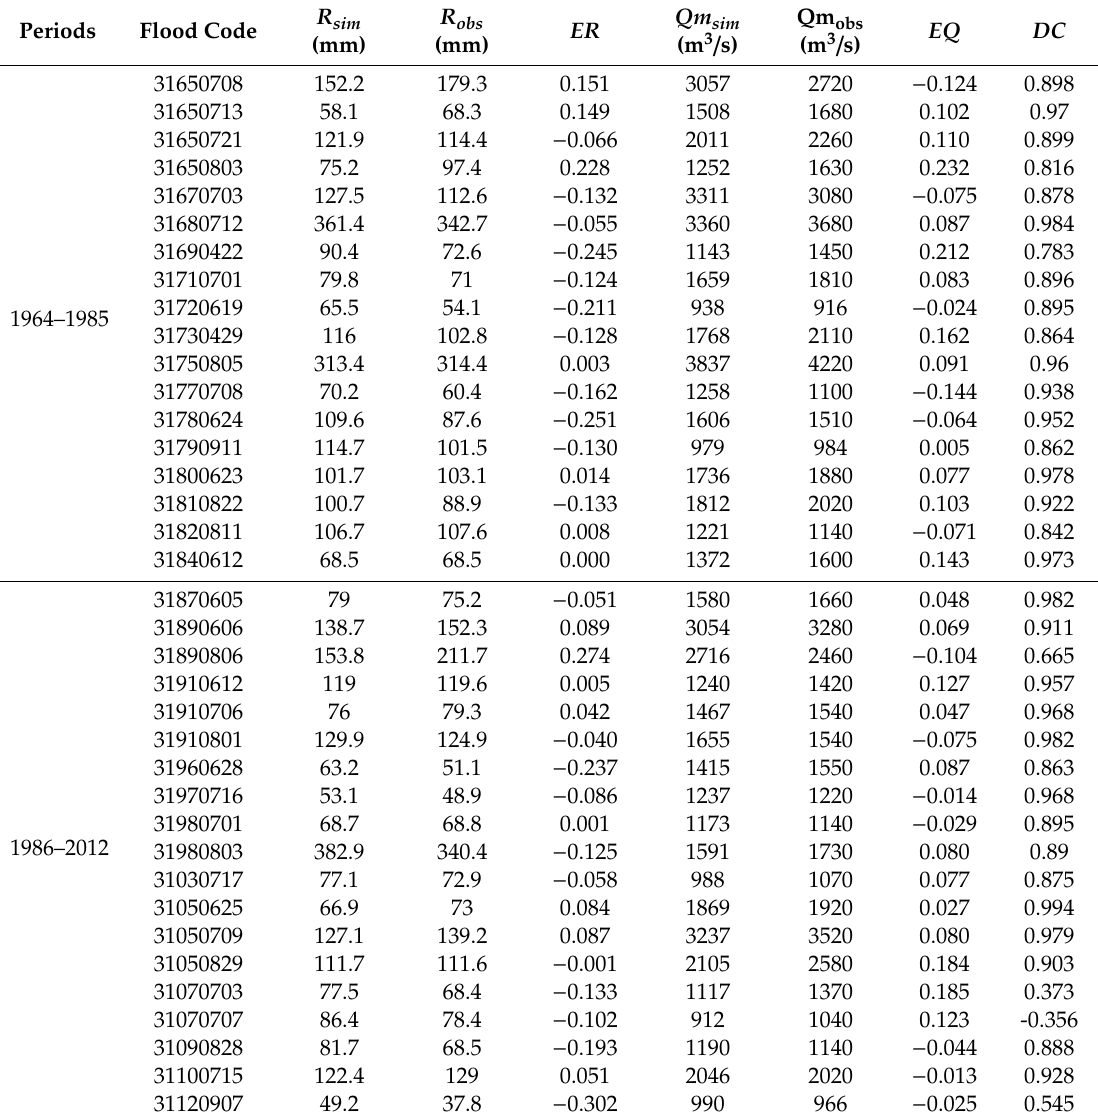
Table 7. The simulation results of Xinanjiang Model in Dapoling